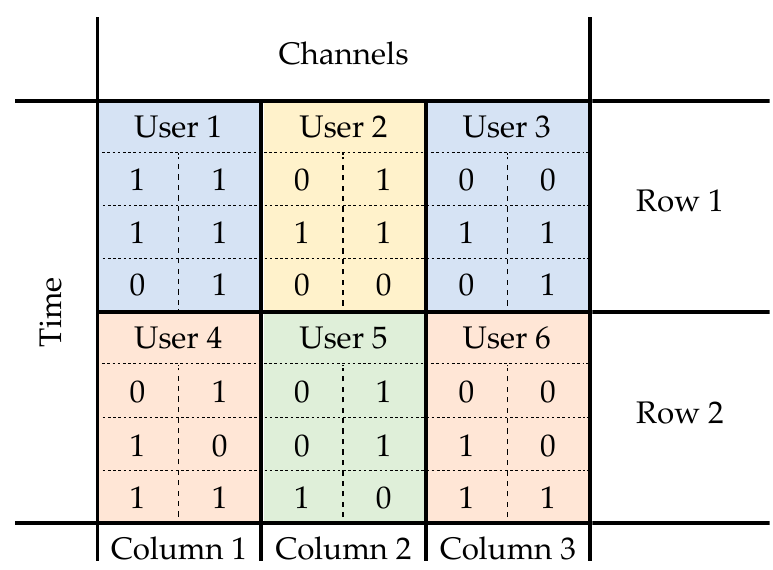
Figure 9. Availability matrix sectioned for six users with column division.